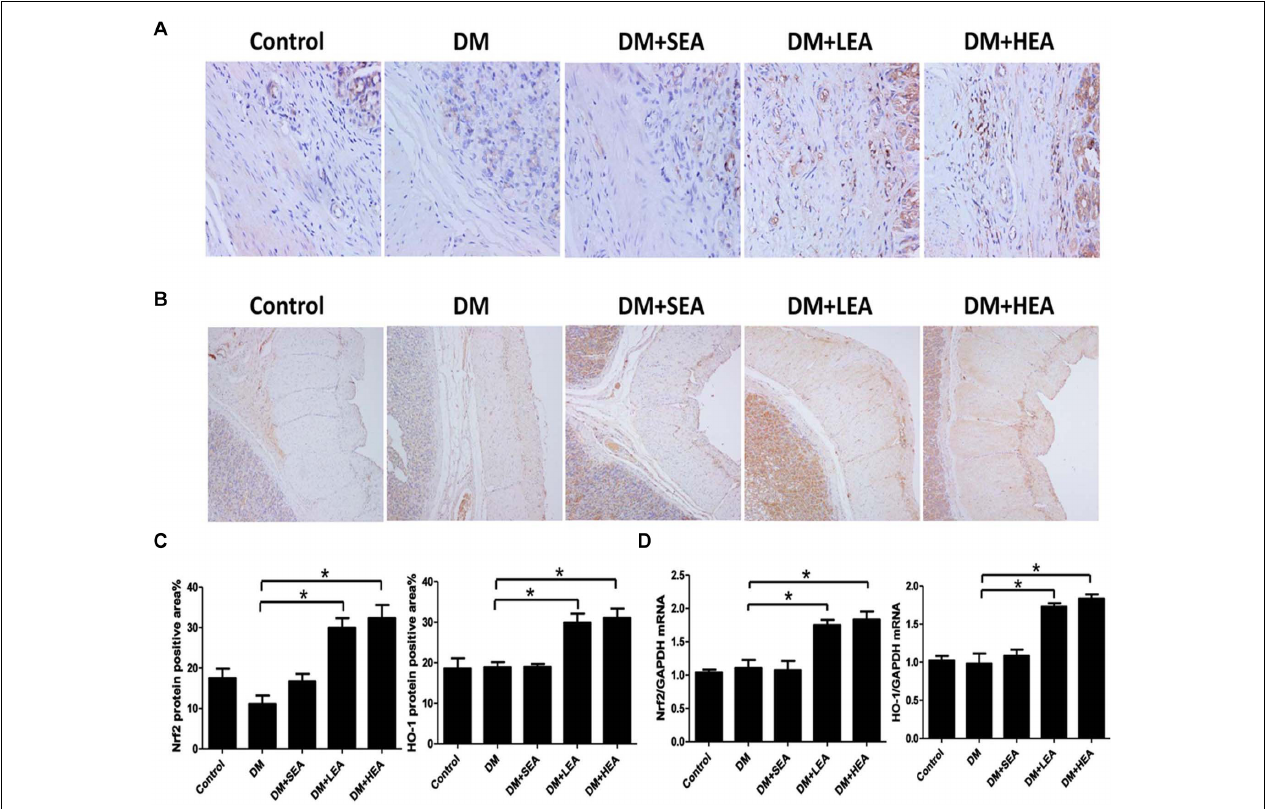
FIGURE 6 | The effects of electroacupuncture (EA) on the expression of nuclear factor erythroid 2-related factor/heme oxygenase-1 (Nrf2/HO-1) pathway. (A) The expression of Nrf2 was increased in the DM group compared with the normal control group, but it was significantly increased in the DM + LEA and DM + HEA groups (400 × ). (B) HO-1 in the DM group was elevated compared with the normal control group. In the DM + LEA and DM + HEA groups, the expression of HO-1 was increased compared with that in the DM group (100 × ). (C) Quantification of Nrf2 and HO-1 protein expressions in the stomach of each group. (D) The mRNA expressions of Nrf2 and HO-1 in the DM group were elevated compared with those in the normal control group. Compared with the DM group, the Nrf2 and HO-1 mRNA expressions were markedly increased in the DM + LEA and DM + HEA groups. One-way ANOVA was used to analyze the data, and the LSD post hoc test was used for the analyses. * P < 0.05 compared with the DM